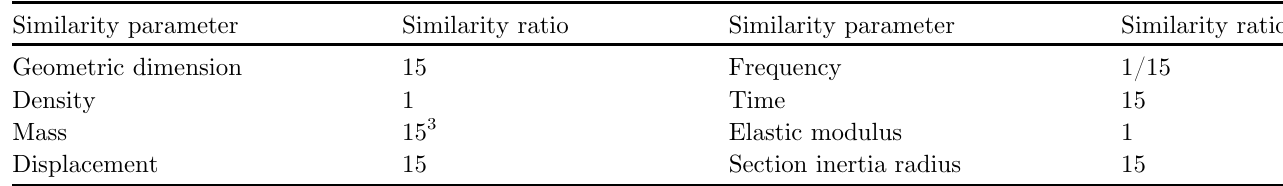
Table 1. Similarity relation of the scale model.